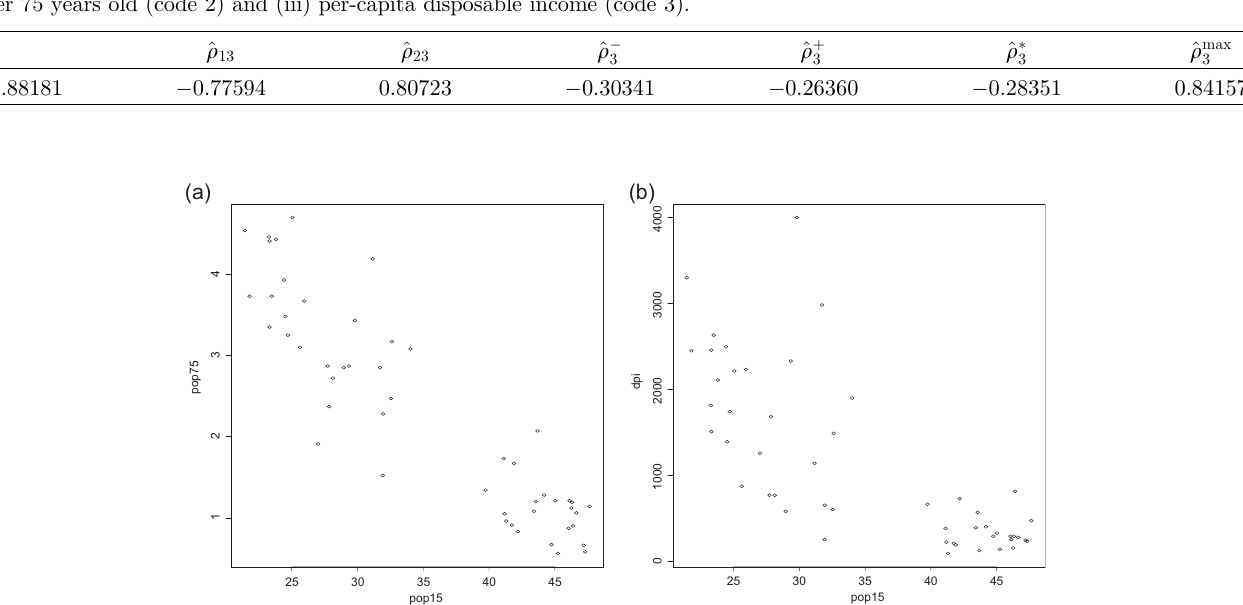
Figure 1. (a) Percentage of population less than 15 years old (pop15) vs. percentage of the population over 75 years old (pop75). (b) Percentage of population less than 15 years old (pop15) vs. per-capita disposable income (dpi). Observations of n = 50 countries (see [6]).